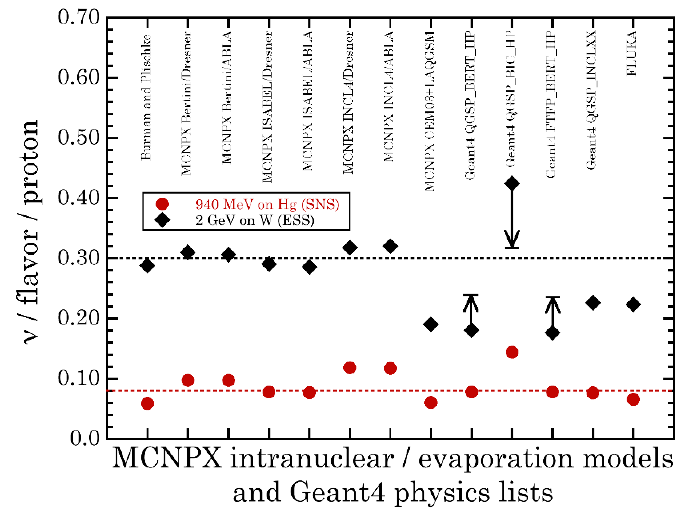
Figure 3 . Neutrino yields for the SNS mercury and ESS tungsten targets, as a function of simu- lation package adopted. The (cid:12)rst column shows predictions from a dedicated calculation [37, 38], validated against neutrino cross section measurements [40]. For three physics lists in common with [48], arrows attempt a correction based on the HARP-CDP (cid:25) + production cross-section for 2.2 GeV protons on Ta. The horizontal red line marks the value used for the CE (cid:23) NS measurement at the SNS [2], whereas the black line shows the value adopted here for the